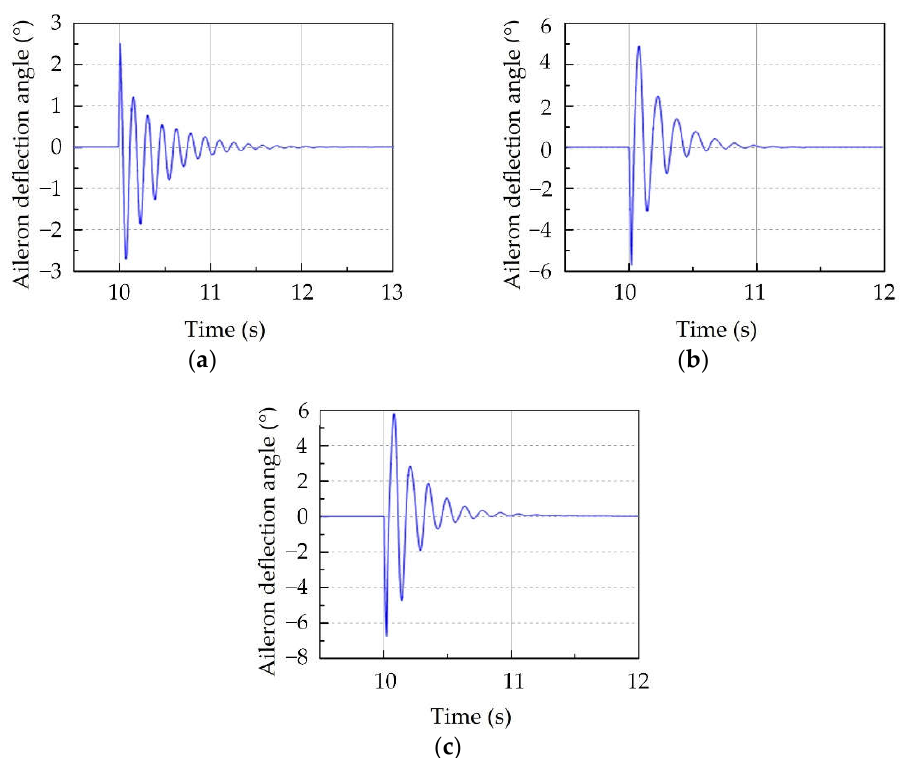
Figure 11. Deflection of aileron at different flight speeds: ( a ) 920 km/h; ( b ) 970 km/h; ( c ) 990 km/h.